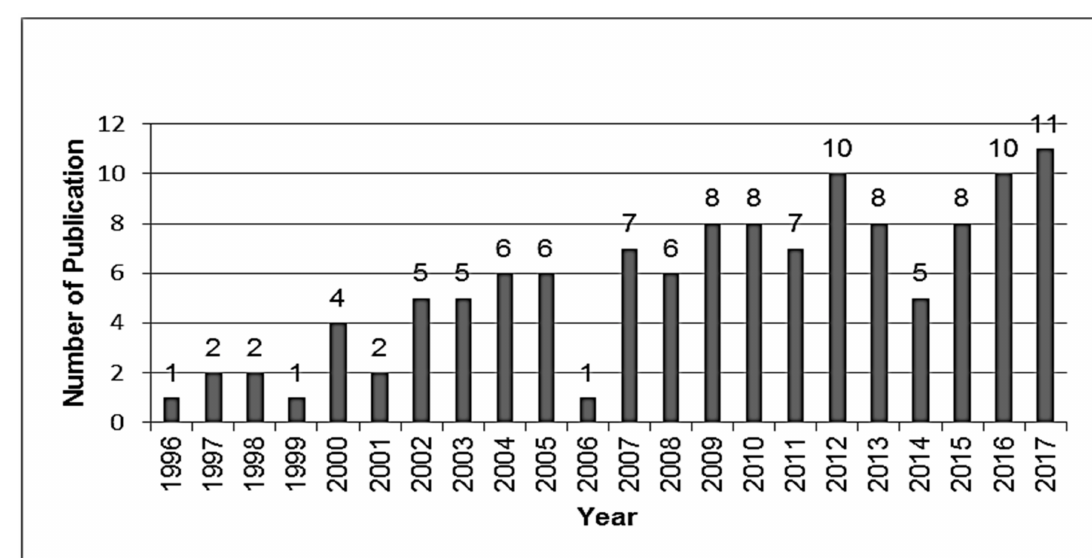
key word (available online on Sciencedirect website: https://www.sciencedirect.com/ (accessed on 20 December 2018, 6:24